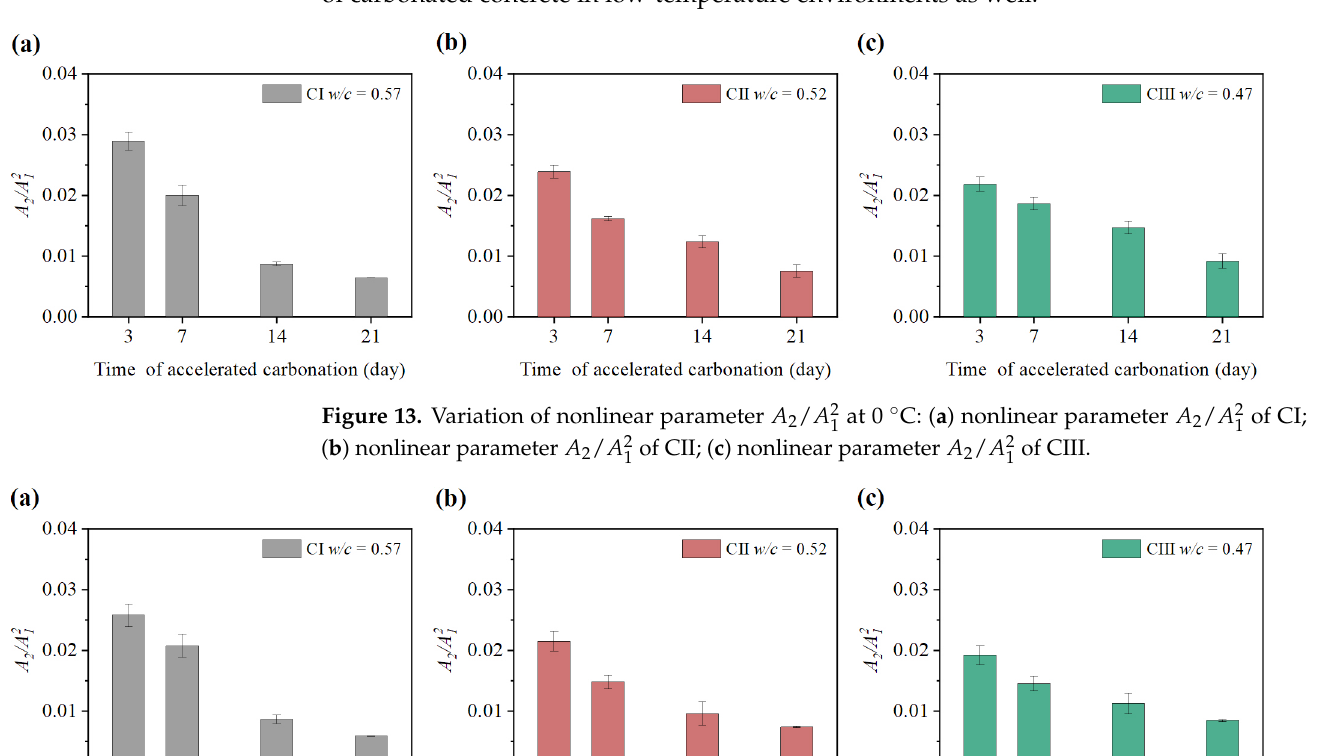
Figure 14. Variation of nonlinear parameter A 2 / A 2 ( b ) nonlinear parameter A 2 / A 2